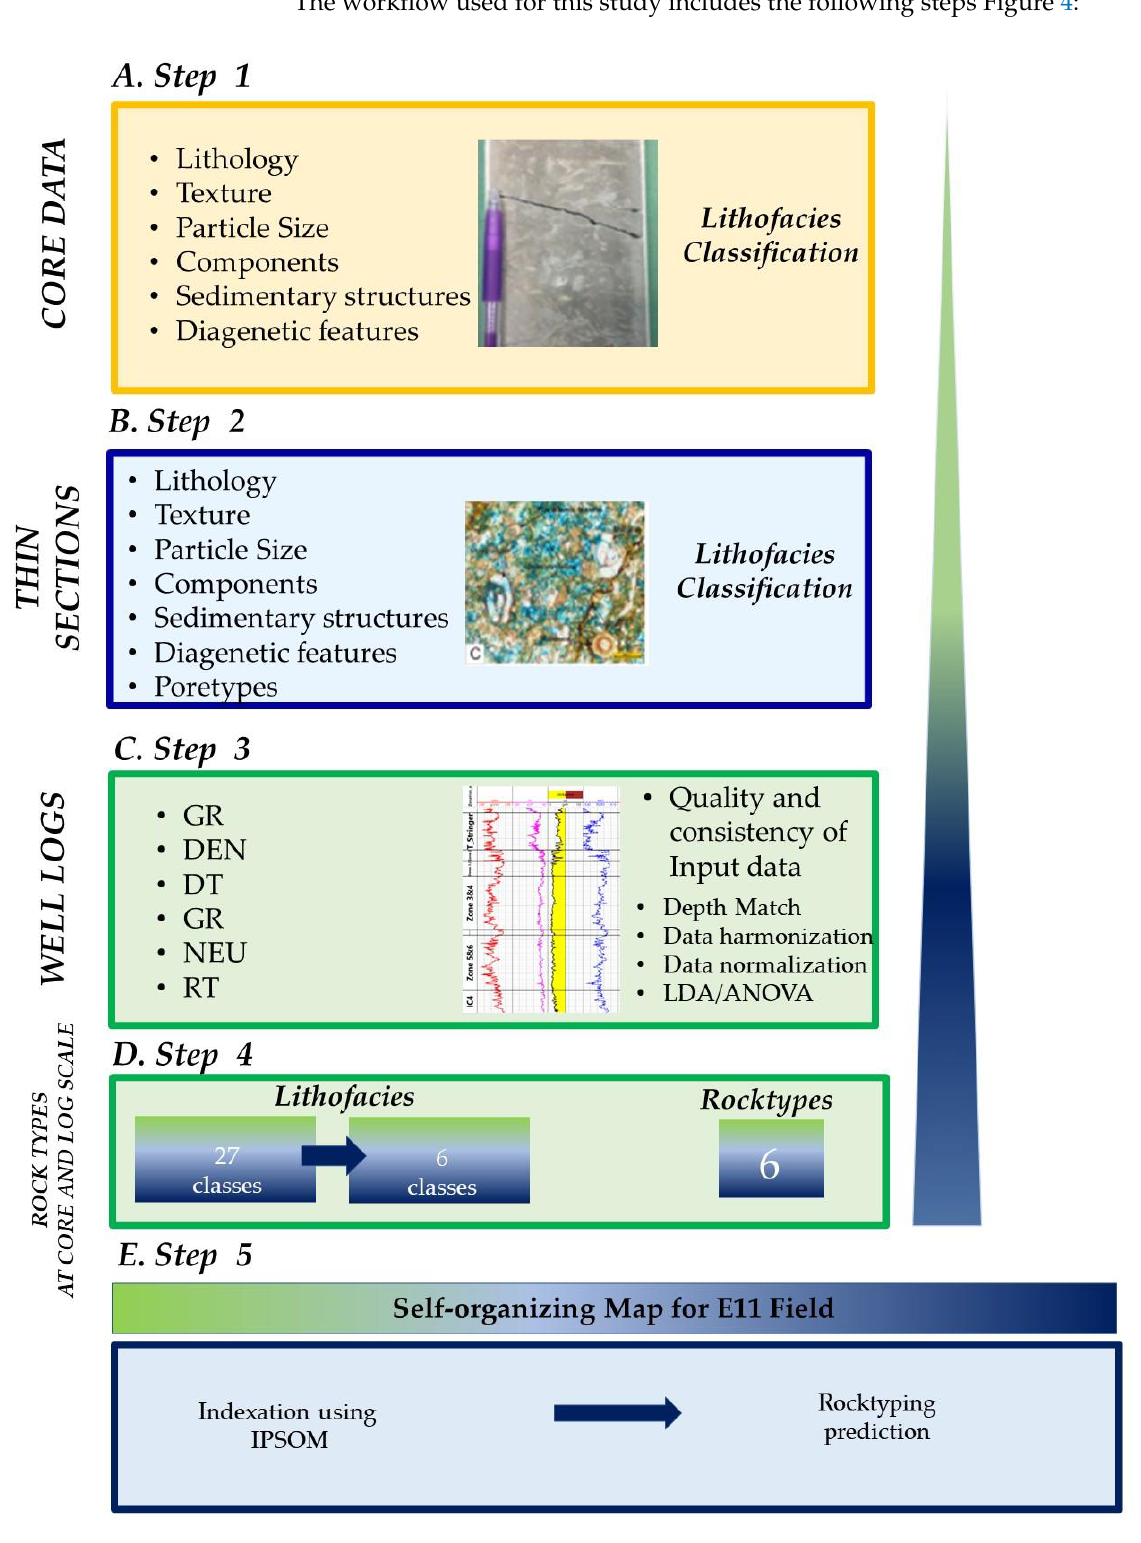
Figure 4. The workflow used for this study. ( A ) Step 1: Core data description, ( B ) Step 2: Thin section